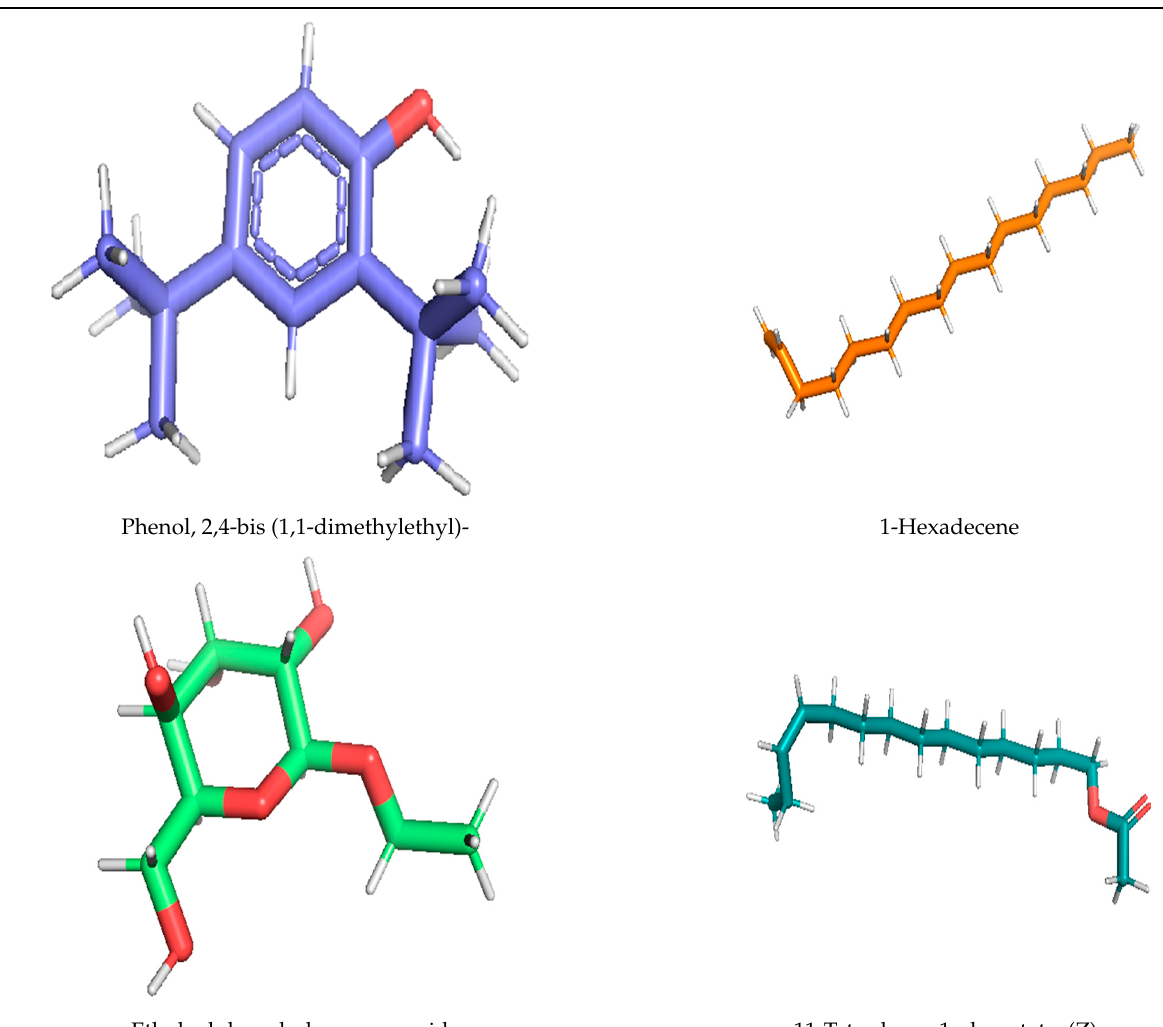
Table 1. Twenty-Five Available 3D Structures of Compounds from PubChem Database and 3D Structures of Selected Target Proteins from Protein Data Bank (PDB).